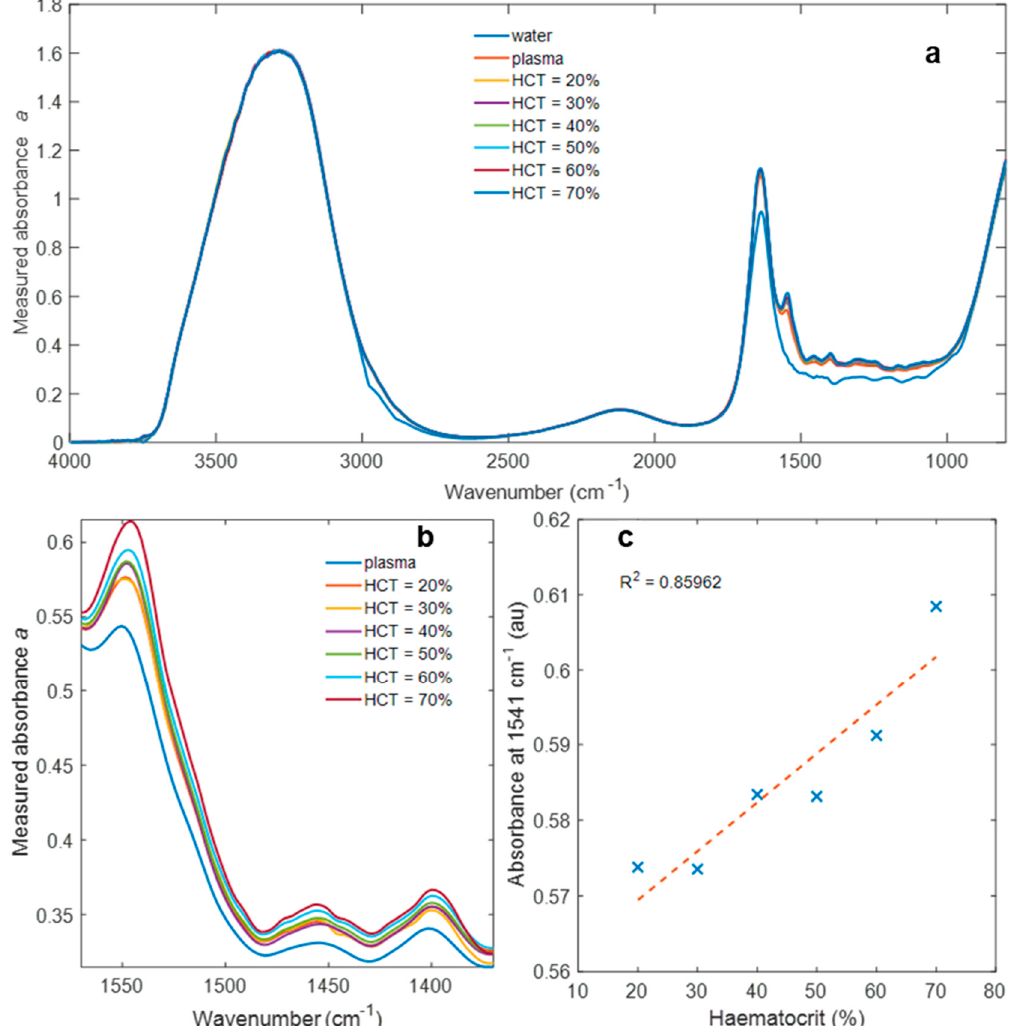
Figure 1. Absorbance spectra of ( a ) DI water, plasma and whole blood with haematocrit in the range 20–70%, ( b ) plasma and whole blood with haematocrit in the range 20–70% over a more limited frequency range (1370–1570 cm − 1 ), and ( c ) absorbance at 1541 cm − 1 with respect to haematocrit.